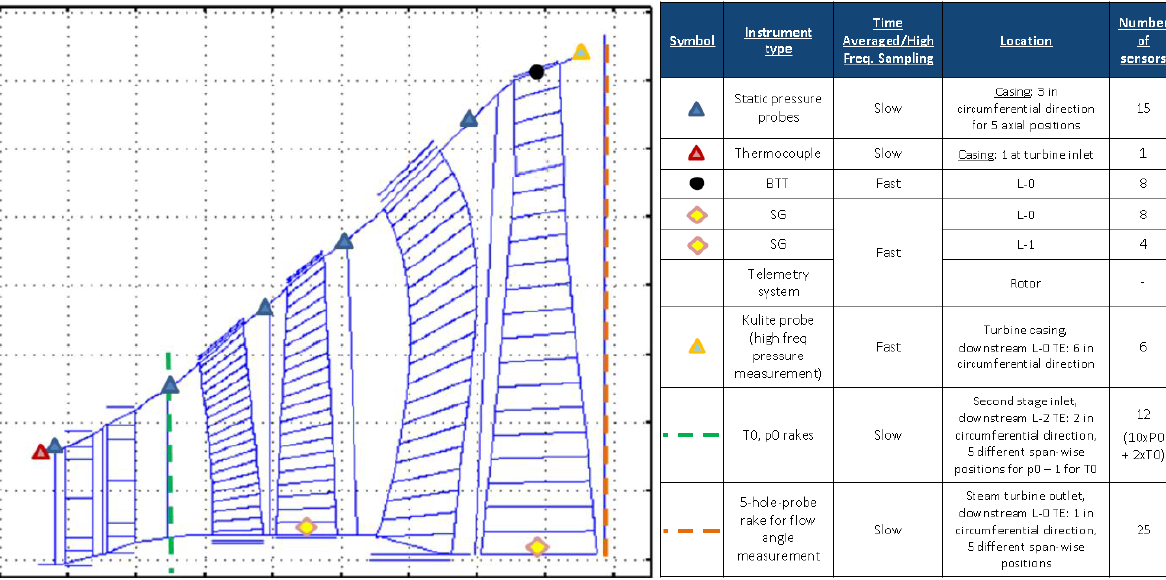
Figure 3. ST instrumentation.